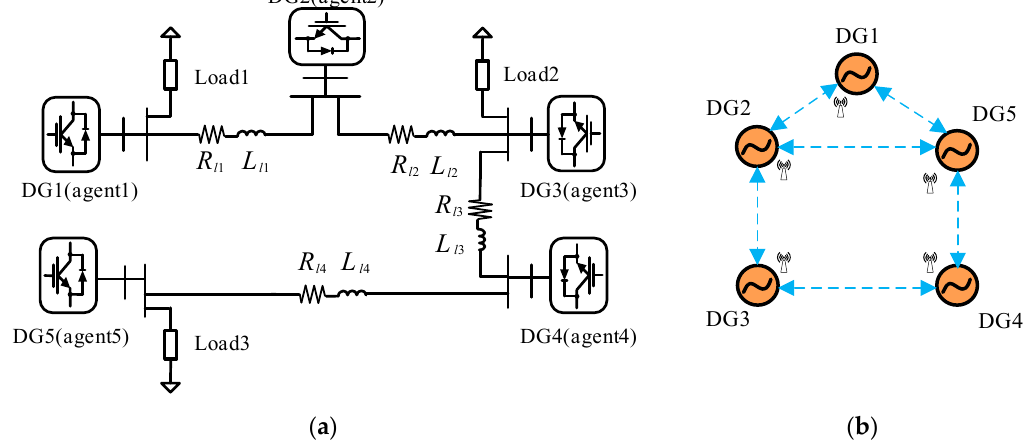
Figure 5. Islanded microgrid test system: ( a ) Physical model; ( b ) Communication topology.